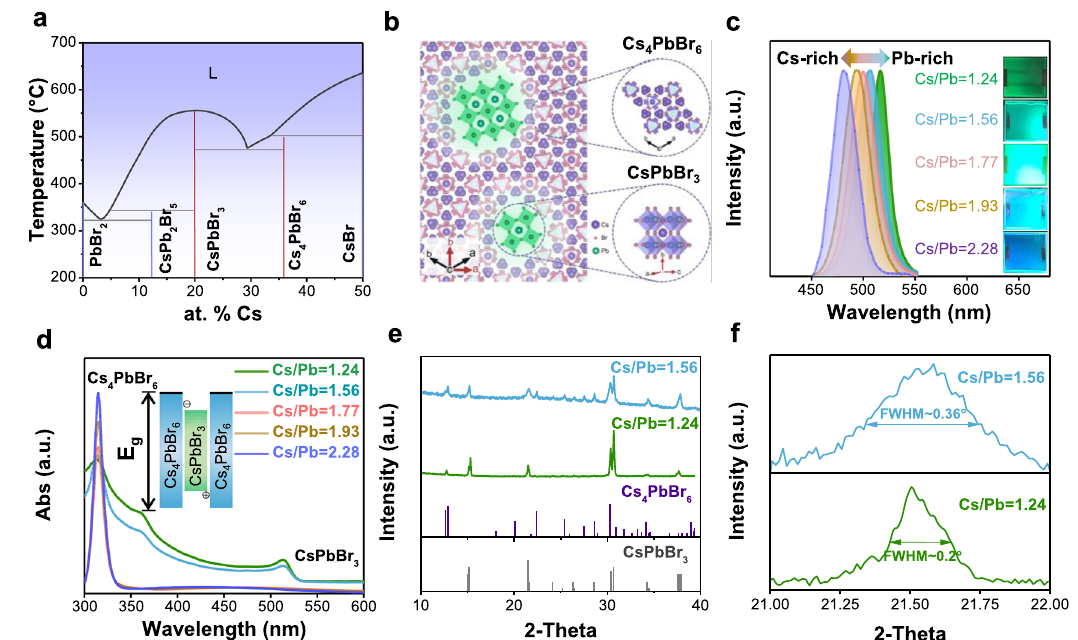
Fig. 1 Characterizations of thermally evaporated Cs-Pb-Br fi lm. a The phase diagram of CsBr-PbBr 2 binary system, which is provided under licence from the online database of SpringerMaterials 49, 50 . b The schematic diagram of CsPbBr 3 embedded in the Cs 4 PbBr 6 matrix, which indicates the 3D [PbBr 6 ] 4 − of CsPbBr 3 is separated by 0D [PbBr 6 ] 4 − of Cs 4 PbBr 6 . c , d The PL ( c ) and absorption ( d ) spectra of Cs-Pb-Br fi lms with various Cs/Pb ratios. e , f XRD ( e ) and its magni fi cation ( f ) for the fi lm of Cs/Pb = 1.56 and Cs/Pb =